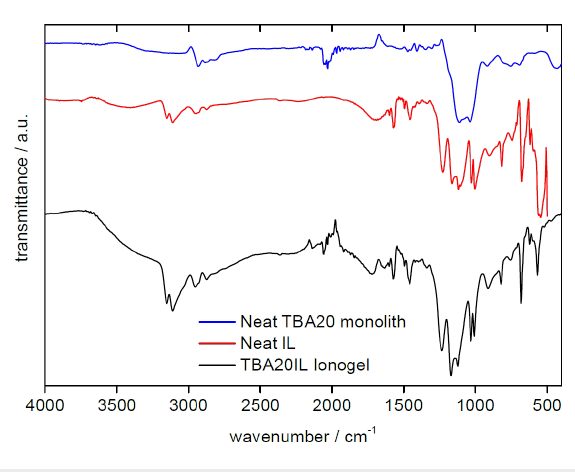
Figure 8: IR spectra of a neat TBA20 monolith, pure IL, and the result- ing TBA20IL